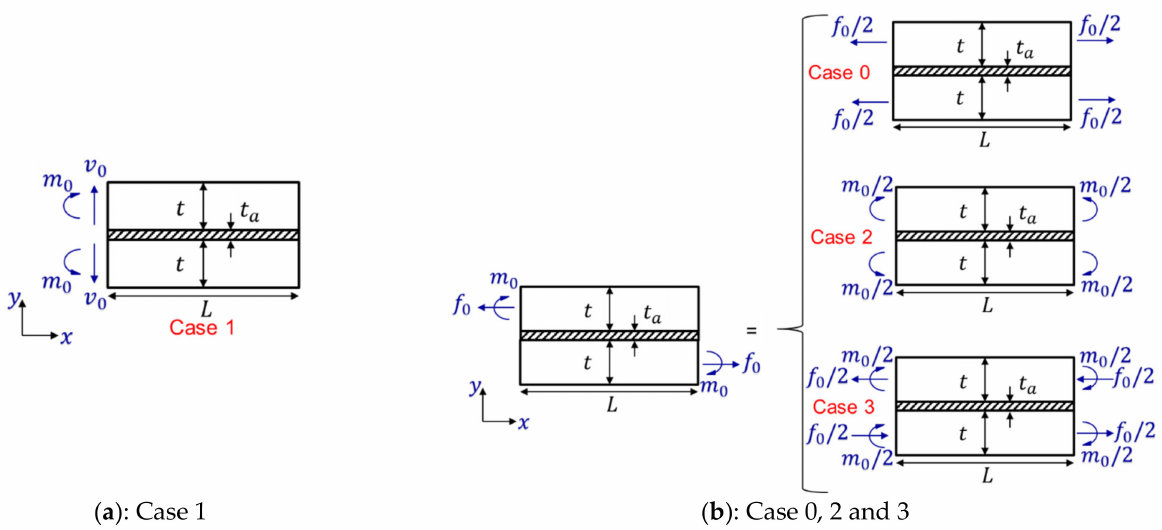
Figure 3. The sandwich model representations of the lap-shear and coach-peel loading conditions through the loading mode deposition. ( a ) Case 1 corresponds to the coach-peel loading condition. ( b ) Cases 0, 2, and 3 correspond to the decompositions of lap-shear loading condition.